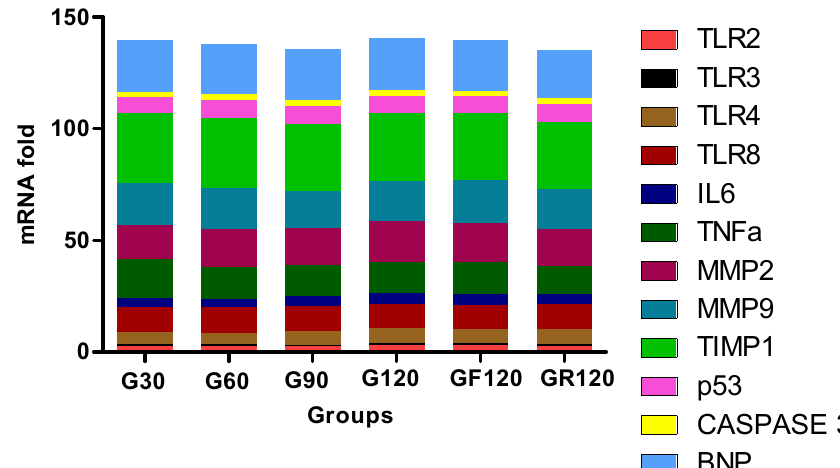
Figure 2. The trend of the biomarkers’ mRNA fold expression in HCD experimental groups.